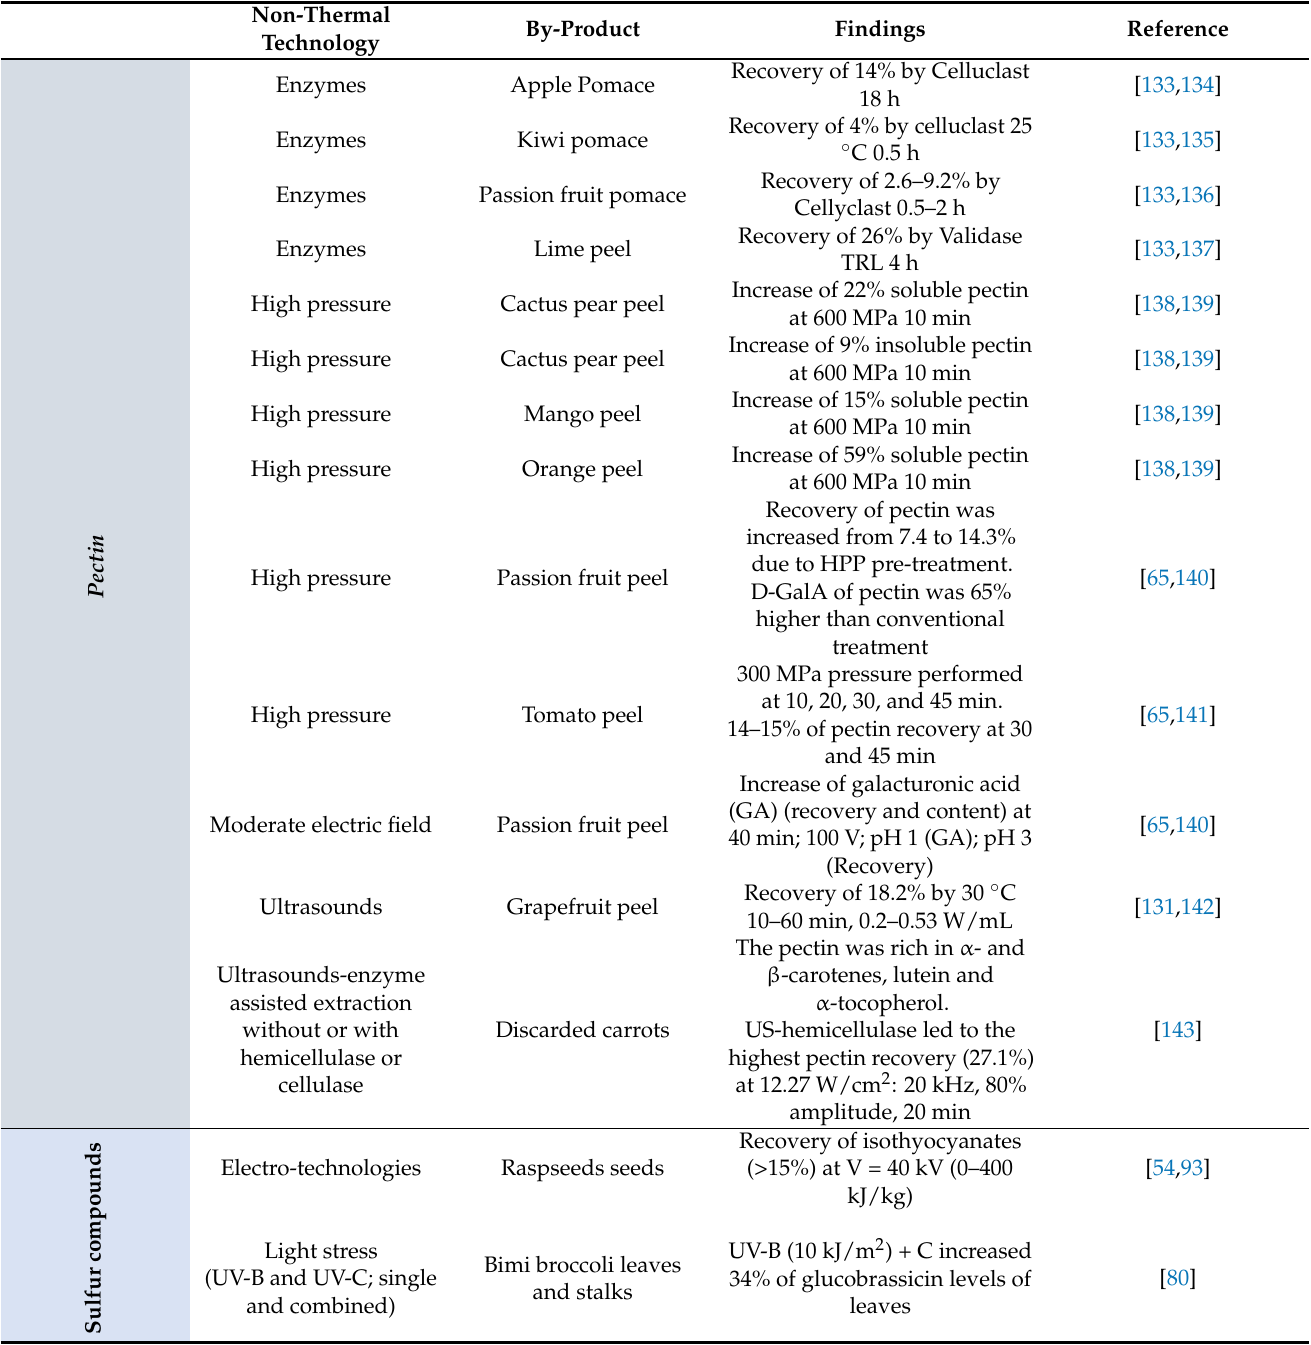
Table 3. Effect of non-thermal technologies on F&V by-products pectin and sulfur components